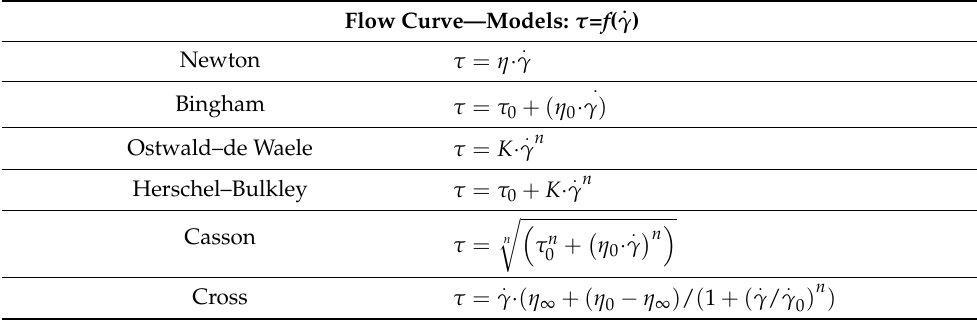
Table 4. Mathematical models for the flow characterization by regression analysis. . Flow Curve—Models: τ = f ( γ ) . Newton τ = η ·